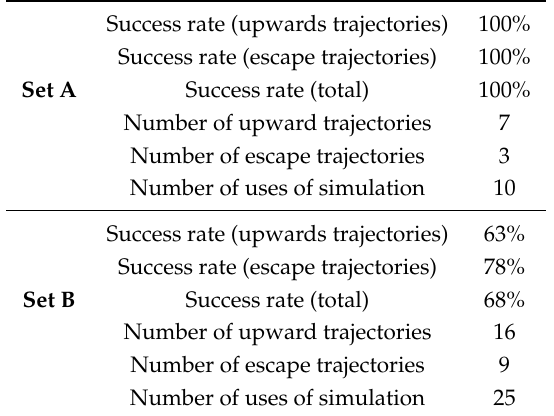
Table 6. Percentages of picking attempts where trajectory evaluation was performed that resulted in a successful pick.